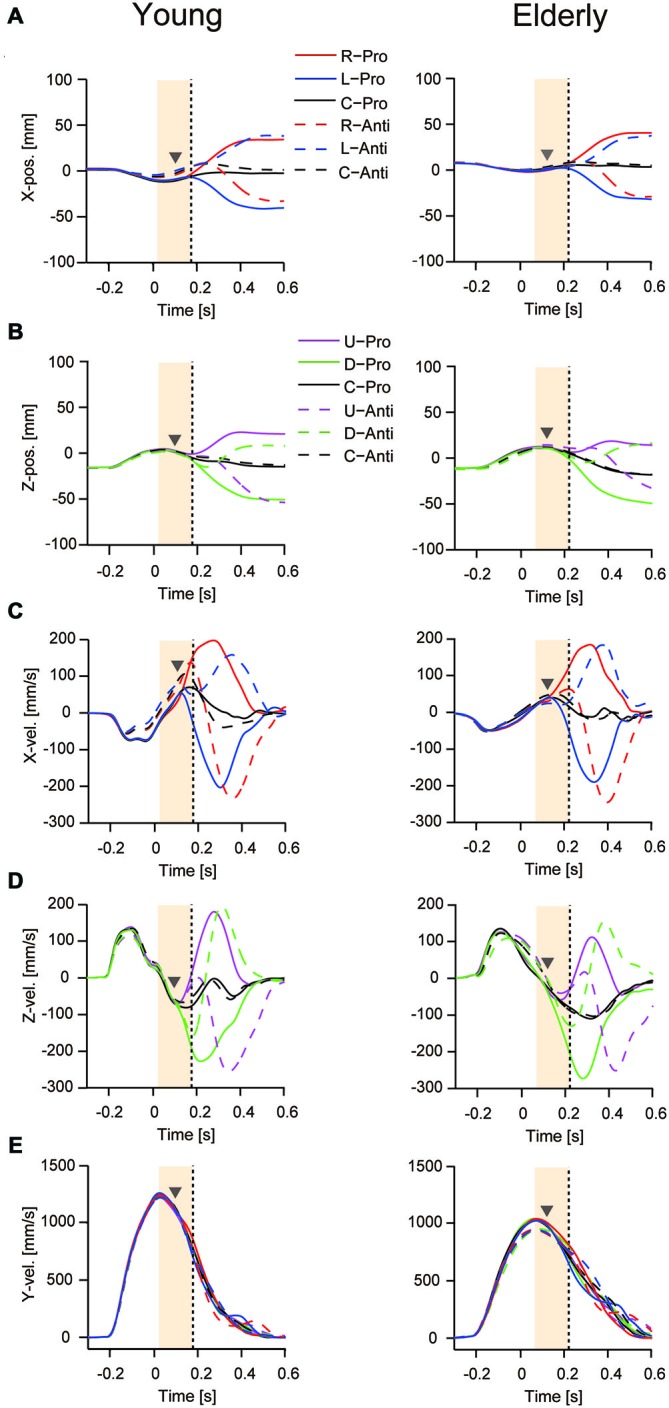
Mean time course for reaching finger displacement and velocity in one young (left panels) and one elderly (right panels) participant during the pro- and anti-tasks. Displacement (A) and velocity (C) for the mediolateral direction with right- and left-ward displacements. Displacement (B) and velocity (D) for the vertical direction with up- and down-ward displacements. Bottom panels are horizontal reaching movement velocities (y-direction) (E). A time of 0 s corresponds to the onset of the target displacement to a new position. Gray triangles represent TJR onset, and vertical dots lines show peak TJR time for each participant. Orange shaded areas show a period for calculating the directional differences of TJR.